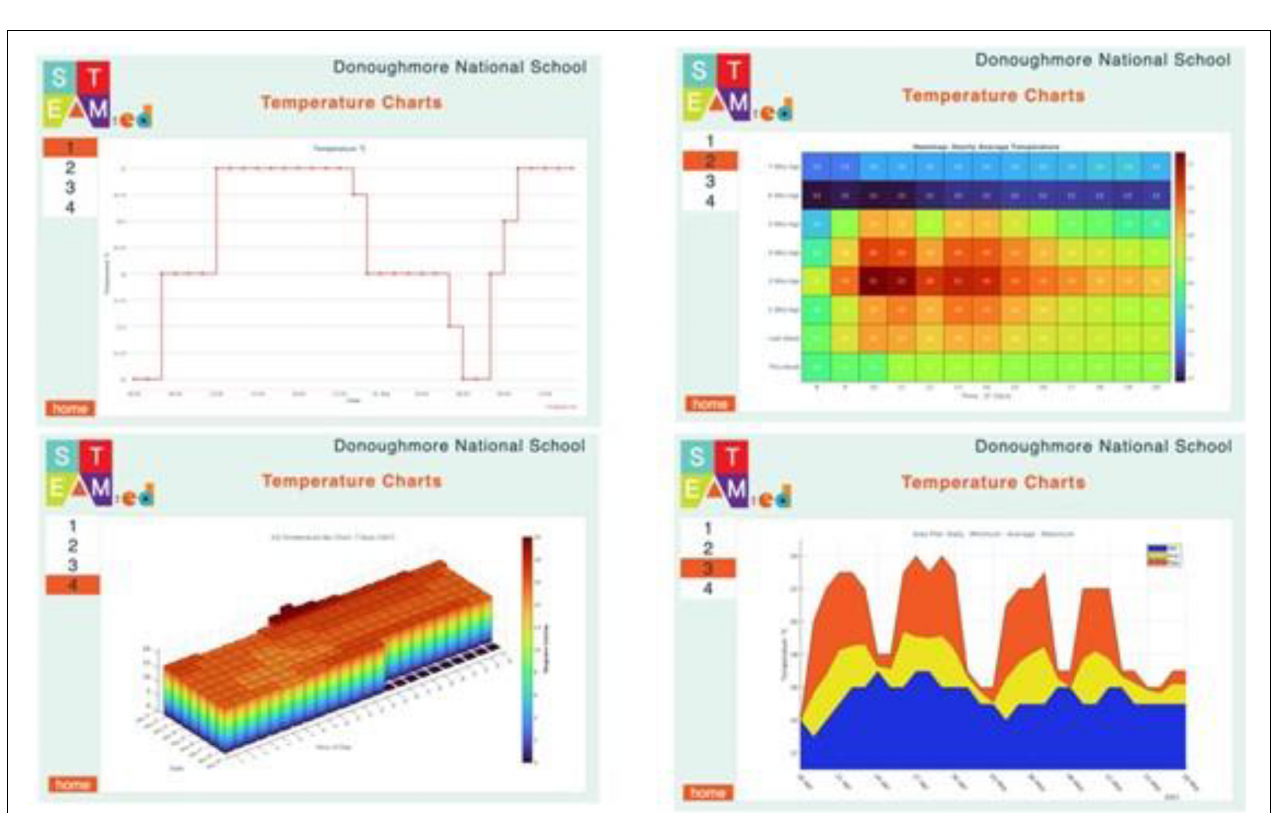
FIGURE 6 | Temperature data represented on a line graph, heat intensity map, area graph, and bar